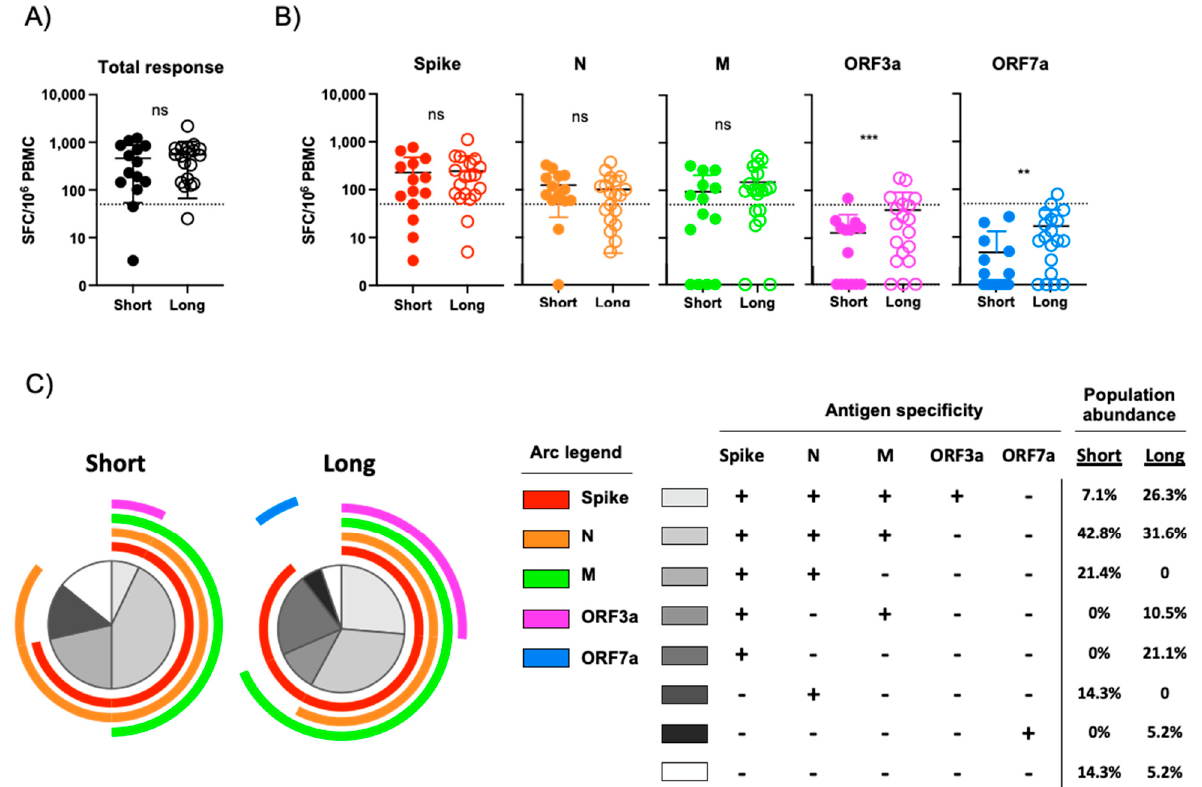
Figure 2. Assessment of SARS-CoV-2-specific cellular immunity by IFN- γ ELISPOT. ( A ) Total magnitude of SARS-CoV-2-specific cellular immunity in all study participants as defined by total reactivity against SARS-CoV-2 spike, N, M, ORF3a and ORF7a antigens. Subjects split by duration of self-reported symptoms. Dashed line indicates a 50 SFC/10 6 PBMC threshold for a positive response. ( B ) Magnitude of SARS-CoV-2-specific cellular immunity separated by major antigen in all study participants. Dashed line indicates a 50 SFC/10 6 PBMC threshold for a positive response. ( C ) Pattern of multi-antigen SARS-CoV-2 reactivity in all study subjects split by duration of self-reported symptoms. Arc color and arc length indicates reactivity against a given SARS-CoV-2 antigen. Internal plot wedge size indicates fraction of individuals with the indicated pattern of antigen reactivity. *** p < 0.001, ** p < 0.01 unpaired 2-tailed t